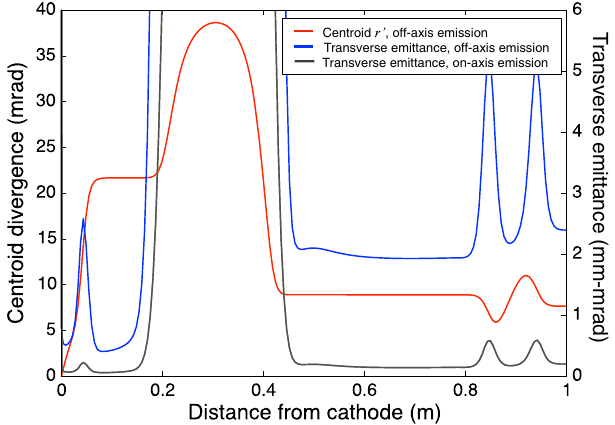
FIG. 5. A close-up view of the behavior in Fig. 4 from the cathode to the exit of the rf buncher, illustrating the effects of rf defocusing in the gun. (Red) Evolution of the centroid divergence angle r 0 ¼ p r =p z for a beam emitted 2 mm horizontally off-axis at the cathode. (Blue) Geometric mean of the horizontal and vertical normalized transverse emittances for a beam emitted 2 mm horizontally off-axis at the cathode. (Black) The corre- sponding transverse emittance for a beam emitted on-axis at the